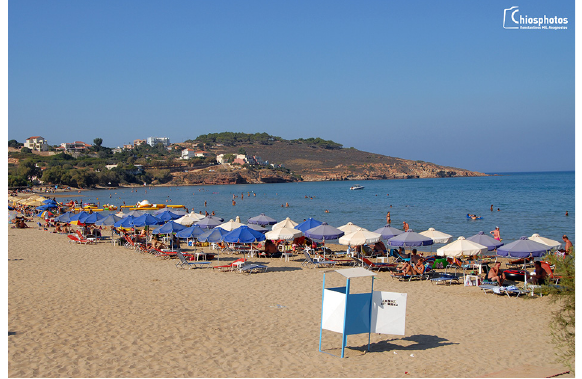
Fig. 5. Chios Island, Greece. The resort of karfas (Source: